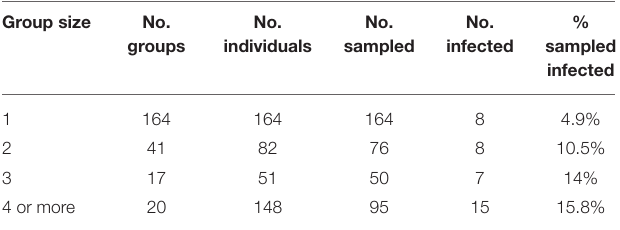
TABLE 4 | Effects of B. luciae group size on Bd infection prevalence: “Group size” = number individuals under cover item; “No. groups” = number of replicate groups found of each size; “No. individuals” = total individuals observed of each group size category; “No. sampled” = number of individuals observed that were swabbed; “No. infected” = number of sampled individuals that were Bd positive.